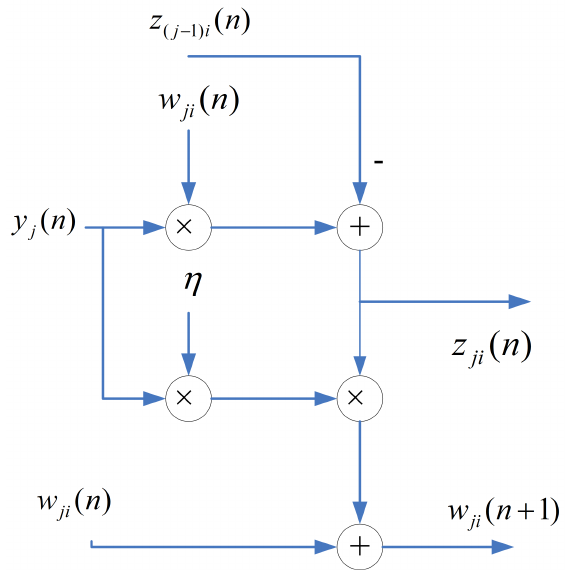
Figure 3. The architecture of each module in the synaptic weight updating (SWU)